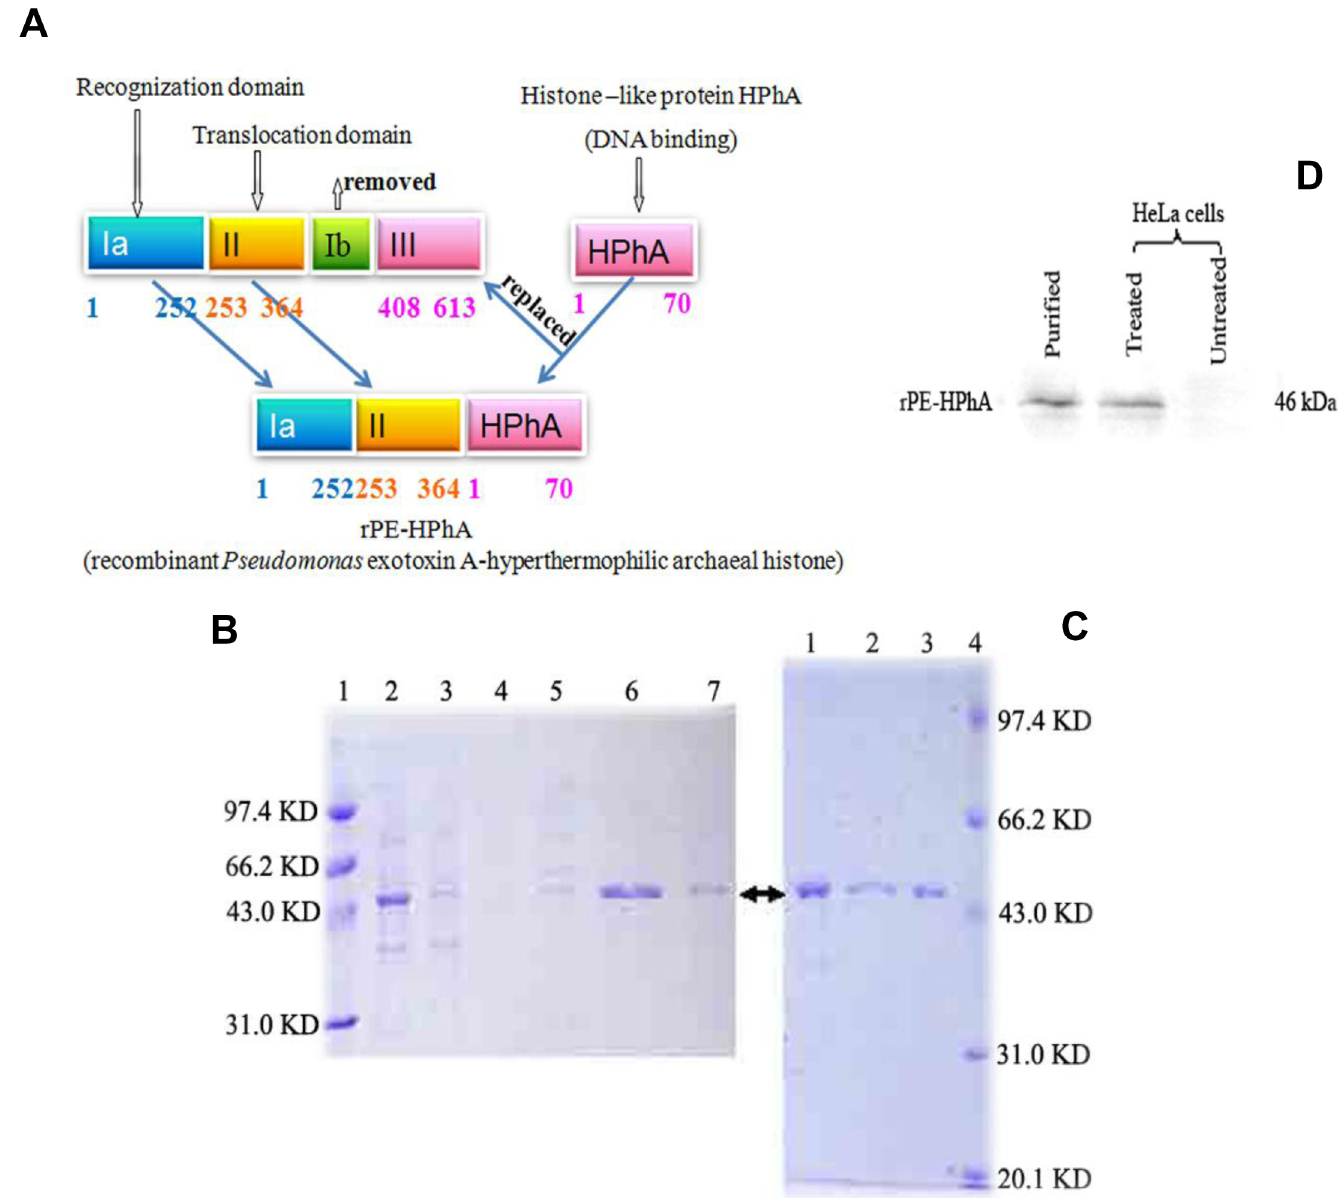
Fig 1. Construction and expression of rPE-HPhA fusion protein. A) Schematic representation of fusion proteins, which consists of an N-terminal amino acids 1 – 364 of PE and 70 amino acids of HPhA. B) SDS-PAGE of rPE-HPhA protein purified with Blue Chelating Sepharose Fast Flow. Lane 1: Marker; Lane 2: Sample digested with DNase I; Lane 3: Unbound proteins eluated with equilibration buffer; Lane 4, 5, 6 and 7: Bound protein eluated with sodium chloride (from 360 to 600 mmol/L). C) SDS-PAGE of rPE-HPhA protein which is further purified with Heparin Chelating Sepharose FF. Lane 1: The proteins eluated with 0.1 mol/L NaOH; Lane 2: Denatured fusion proteins; Lane 3: Desalted samples; Lane 4: Marker. D) Immunoblot analyses of